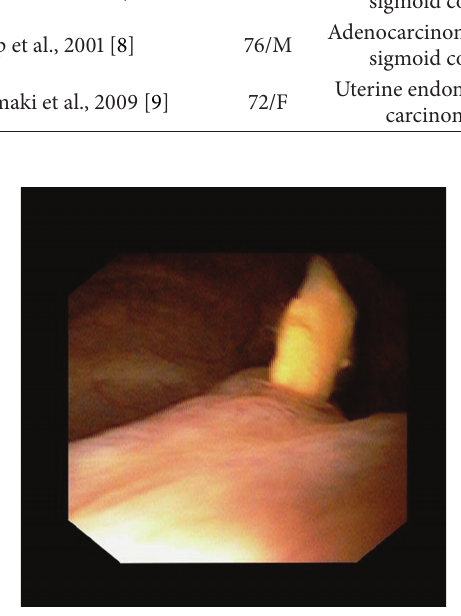
Figure 1: Cystoscopy showed the tumor emanating from the left ureteral orifice.